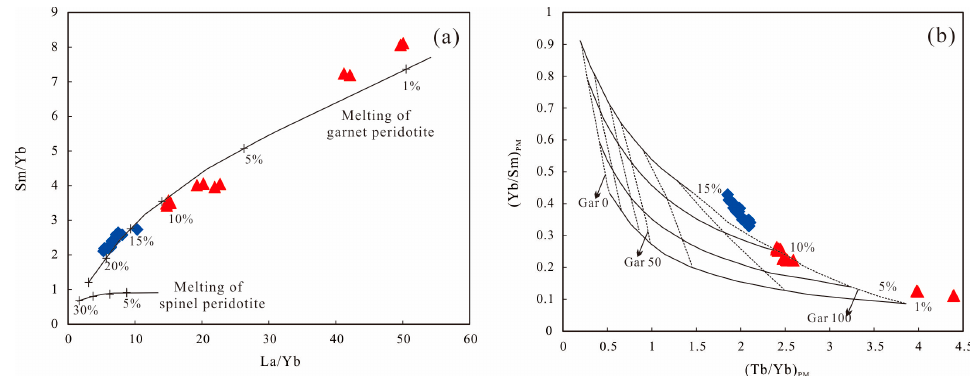
Figure 14. ( a ) La / Yb vs. Sm / Yb for the mafic rocks. Also shown are batch melting curves calculated for garnet peridotite and spinel peridotite. Partition coe ffi cients are taken from [86]. ( b ) (Tb / Yb) PM versus (Yb / Sm) PM for the for the samples from the Qianjiadian region. The black thick lines represent 1%, 5%, 10%, and 15% of aggregated fractional melting of peridotite and the dotted curves suggest the percentage of melt contribution from a garnet-facies mantle (Gar); e.g., Gar 100 corresponds to the melt from garnet peridotite and Gar 0 corresponds to the melt from spinel peridotite. The inverse modeling used here follows